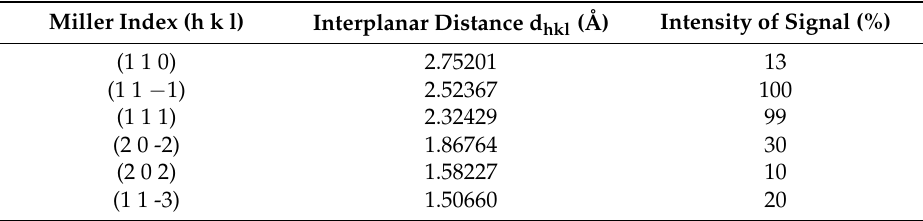
Table 2. Interplanar distances and intensity signals for different atomic planes in CuO (JCPDS 00-048-1548)